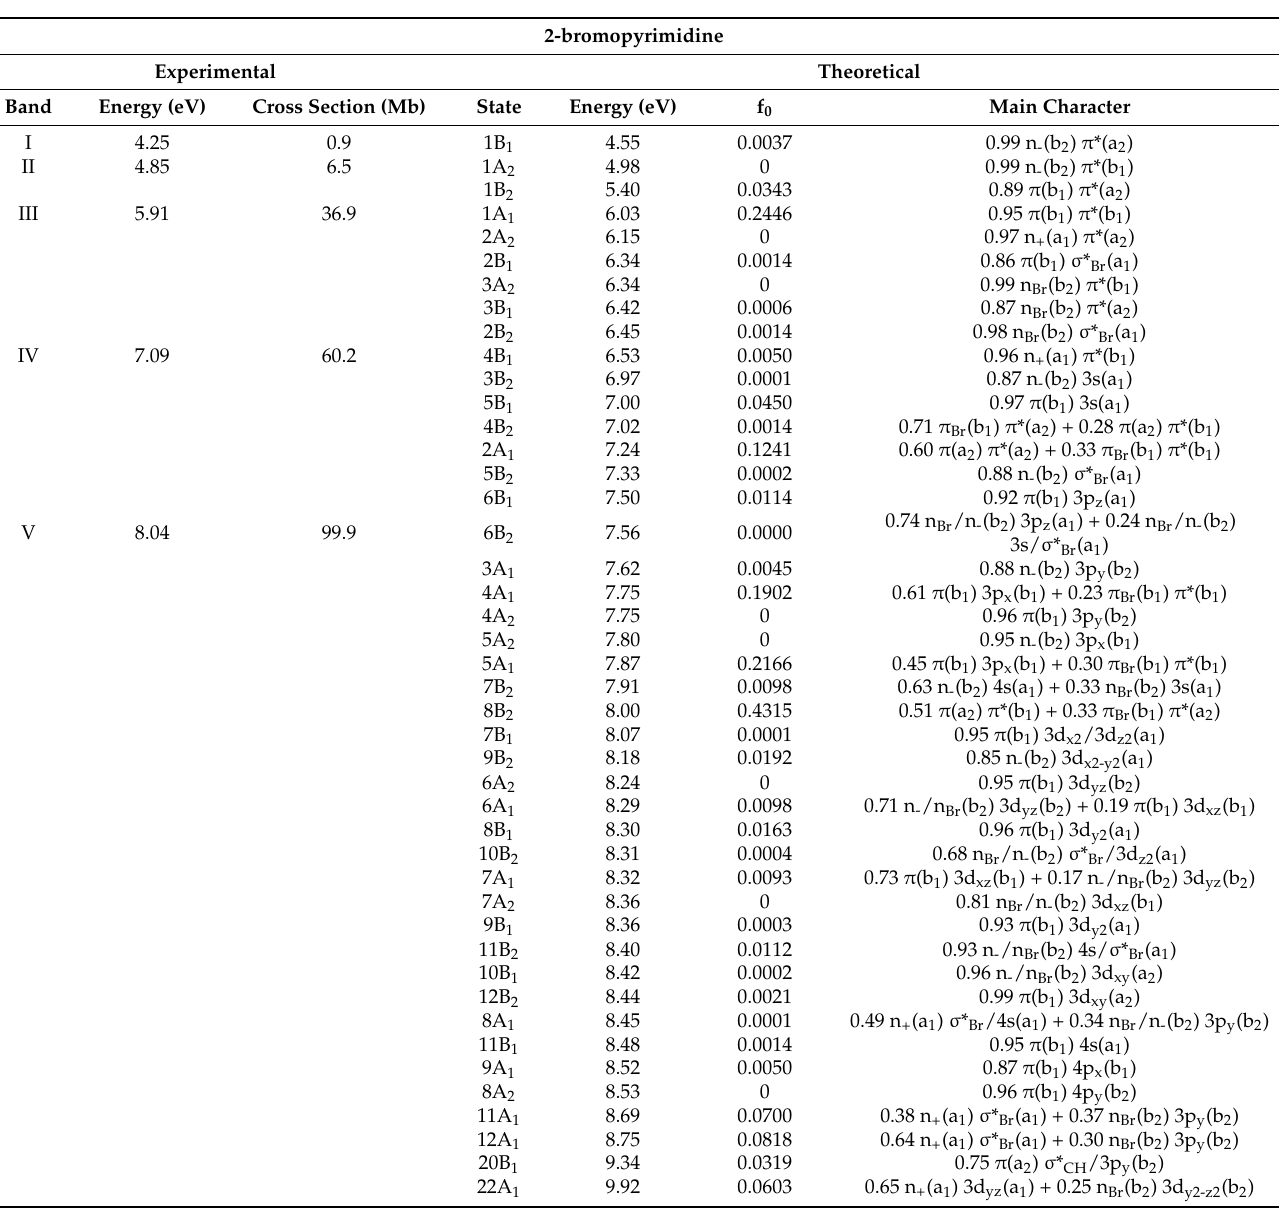
Table 1. Calculated vertical excitation energies and vertical oscillator strengths (f 0 ) of 2-bromopyrimidine, computed at the CAM-B3LYP/aug-cc-pVDZ+2s2p2d level of theory, compared with the experimental data. In the main character column, we present the dominant hole and particle natural transition orbitals and their corresponding occupation numbers.